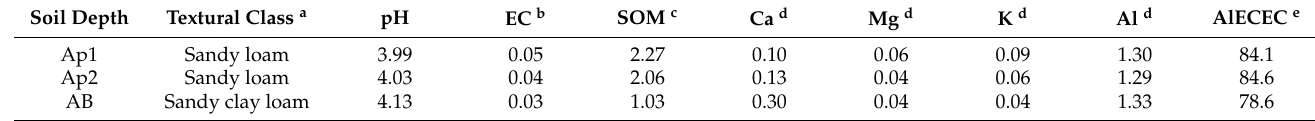
Table 3. Baseline soil horizons characteristics before liming for Ap1 (0–12 cm), Ap2 (12–25 cm) and AB (25–35 cm). Soil Depth Textural Class